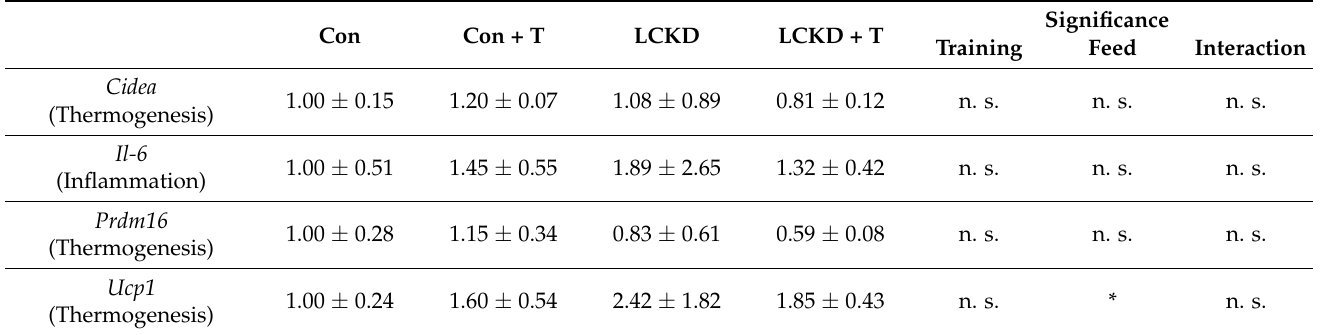
Table 8. Effect of LCKD feeding and/or training on BAT gene expression.